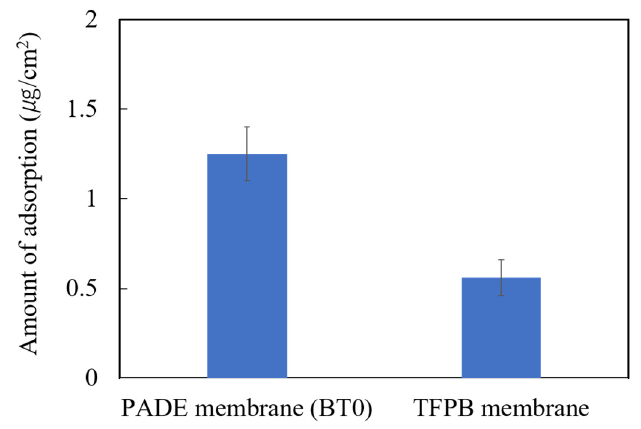
Figure 7. Amount of adsorbed quinine hydrochloride (0.1 mM) on BT0 (PADE-BBPA-TBAC) and TFPB- BBPA-TBAC membrane. The results are expressed as the means ± SD ( n = 6, 3 membranes × 2